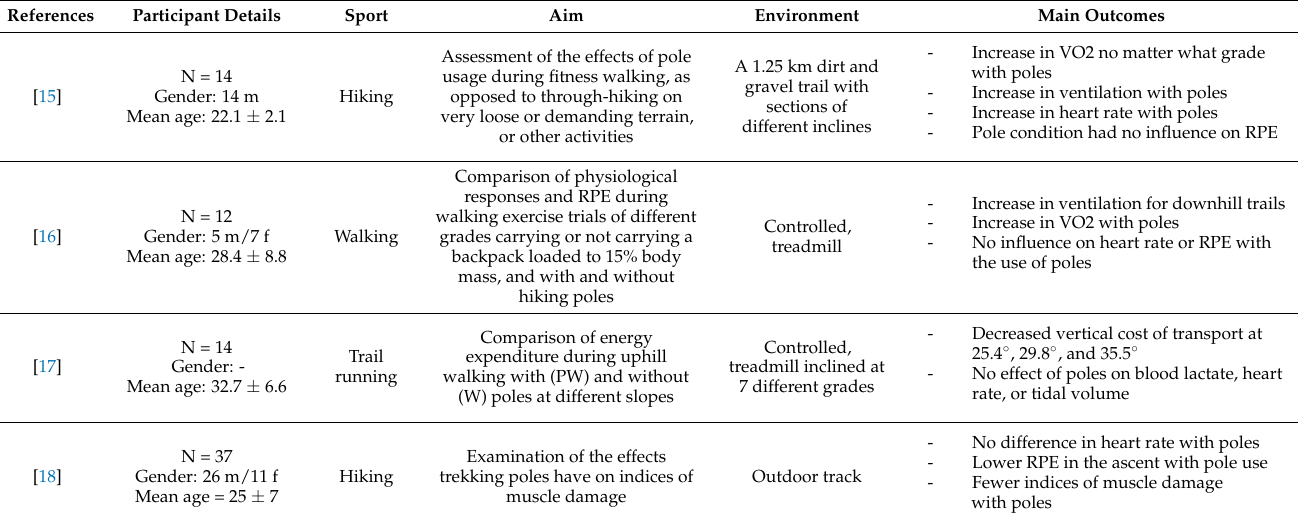
Table 2. Physiological aspects of pole